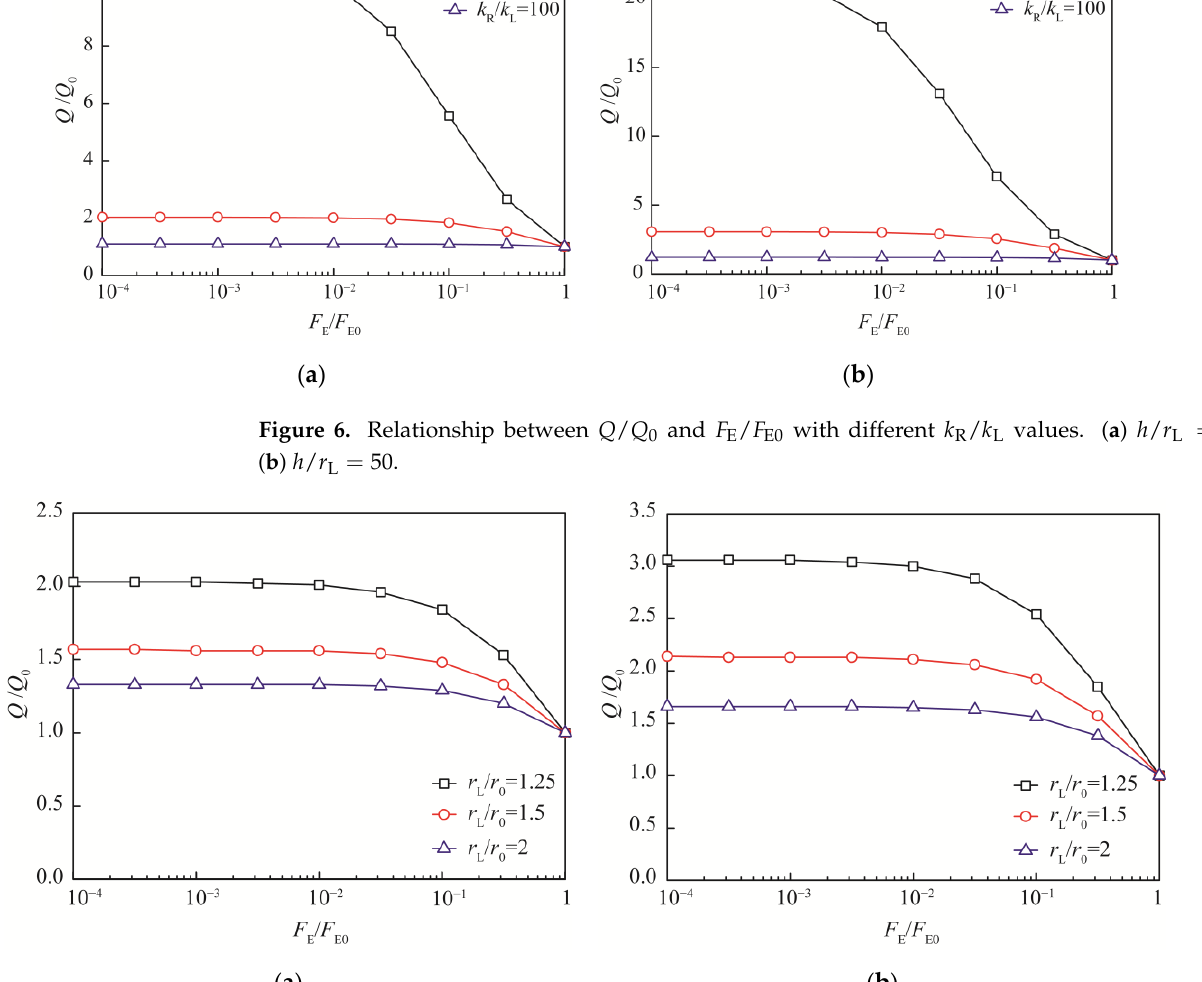
Figure 7. Relationship between Q / Q 0 and F E / F E0 with different r L / r 0 values. ( a ) h / r L = 5; ( b ) h / r L = . Table 4. Computational analyses for